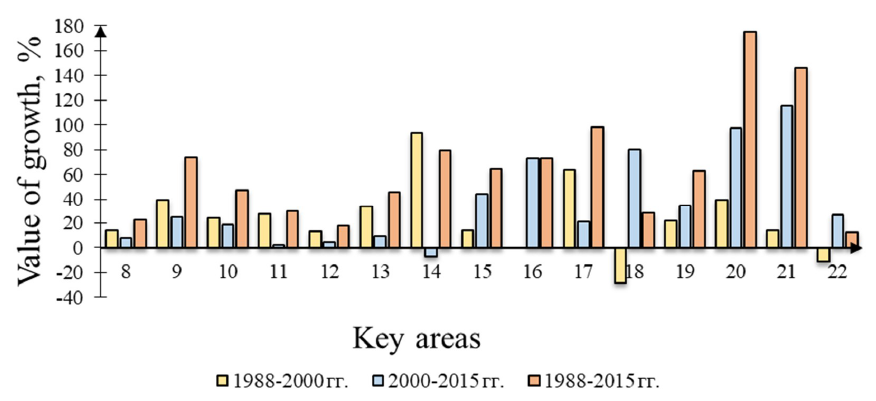
Figure 6. The density dynamics of the ephemeral gully network (the Samara River basin, Orenburg Region) for the periods 1988–2000, 2000–2015 and in general from 1988 to 2015.